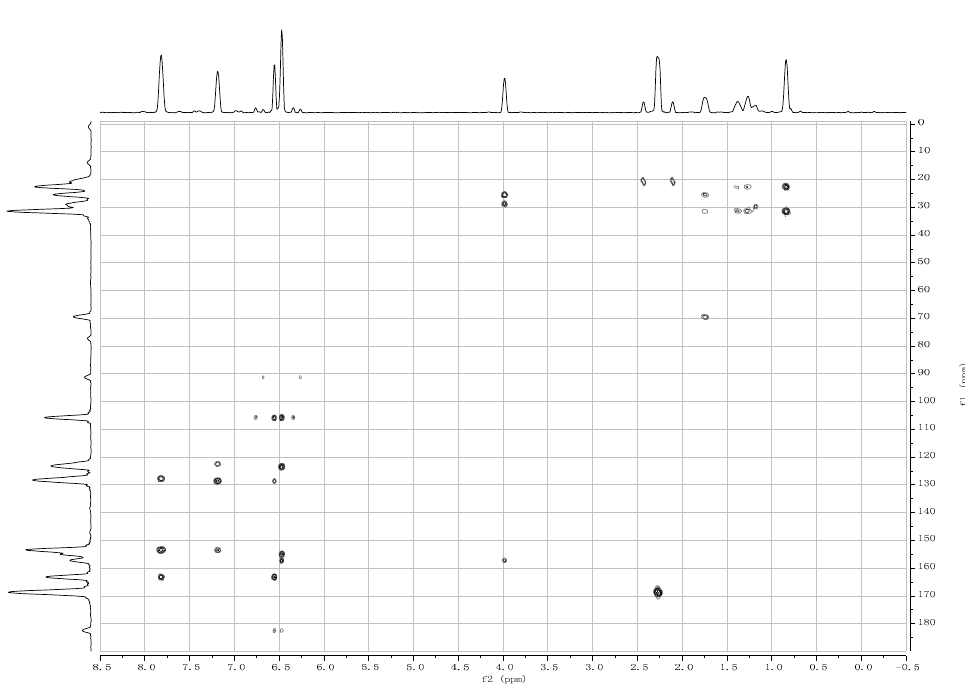
Figure 2. HMBC spectrum of 5d .